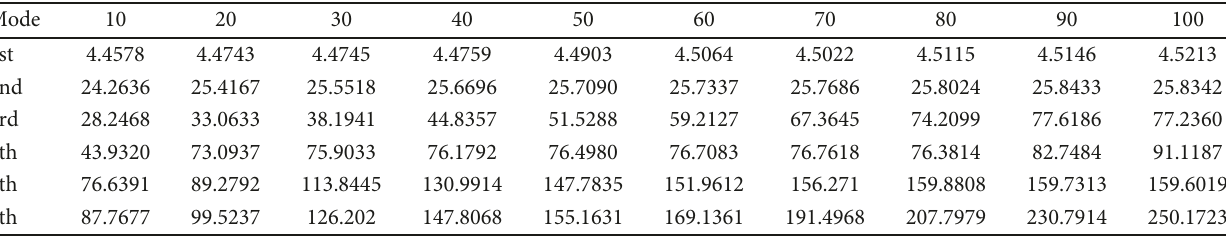
Table 7: Nondimensional frequency parameters for the fi rst six modes of the FG sandwich blade with varying thickness ratio ( l = 3 , n = 2 , = 1/2 , and θ = 30 ° h l